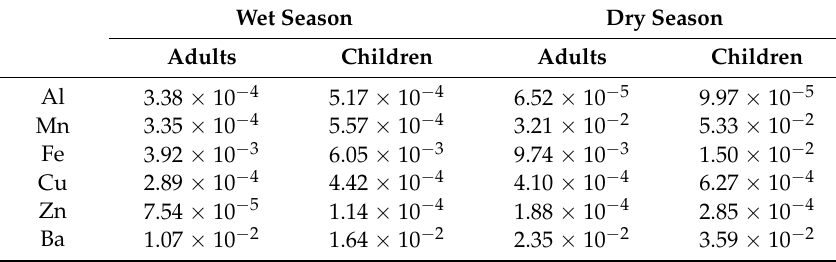
Table 6. Hazard index (HI) values for dissolved heavy metals in the Mun